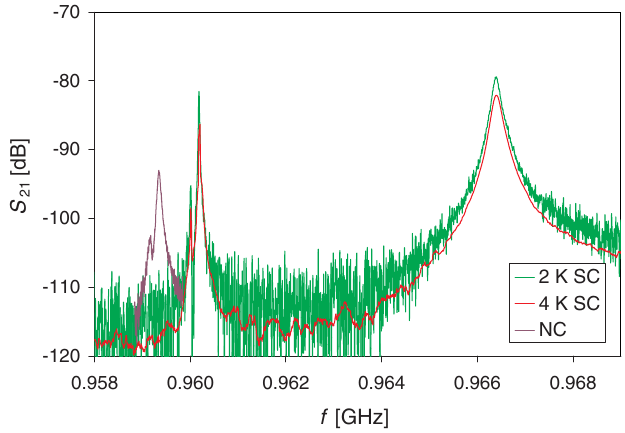
FIG. 7. Comparison of the resonance curves of the quasi- trapped mode (left) with the neighboring damped mode (right). The direct Q measurements at left are 9 500, 44 200, and 47 800 for NC, 4, and 2 K. Also seen is the frequency shift in the left resonance due to the